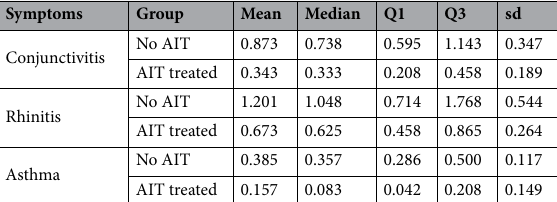
Symptoms Group Mean Median